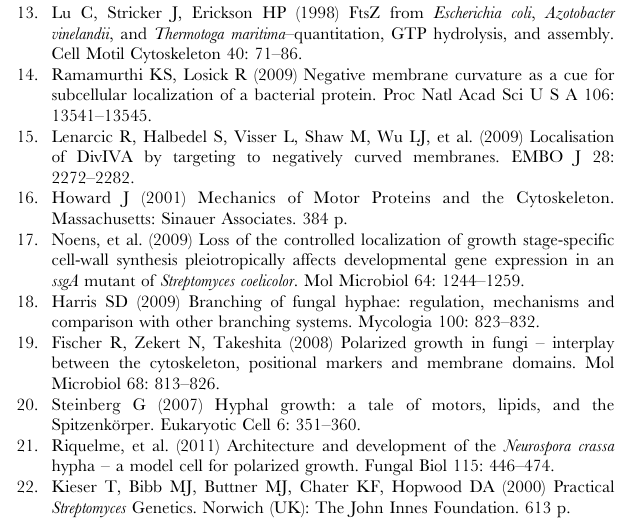
Figure S7 Behaviour of the mode of the tip-to-branch distance distribution as a function of various model parameters, for both an infinite trim (blue line) and an 80 m m trim (red line). The infinite trim line is always higher than the 80 m m trim line. The black dotted line shows the wild-type parameter value. (A) As a function of the binding parameter, b . (B) As a function of the mean initial focus size, S N 0 T . (C) As a function of the mean focus size for branch initiation, S N br T . Figure S8 Comparison of distributions between the minimal model and experimental data at 60 m m trim. Analytic tip-to- branch distribution is also shown (curved line). (A) Tip-to-branch distribution. 1876 experimental data points. (B) Zoomed tip-to- branch distribution. (C) Branch-to-branch distribution. 1215 experimental data points. Figure S9 Comparison of distributions between the minimal model and experimental data at 100 m m trim. Analytic tip-to-branch distribution is also shown (curved line). (A) Tip-to-branch distribution. 297 experimental data points. (B) Zoomed tip-to-branch distribution. (C) Branch-to-branch distribution. 257 experimental data points. Figure S10 Schematic of colony morphology for various values of the binding parameter, b . Red dots represent DivIVA foci. (A) Small value of b . (B) Wild-type value of b . (C) Large value of b . (EPS) Text S1 Supporting text.